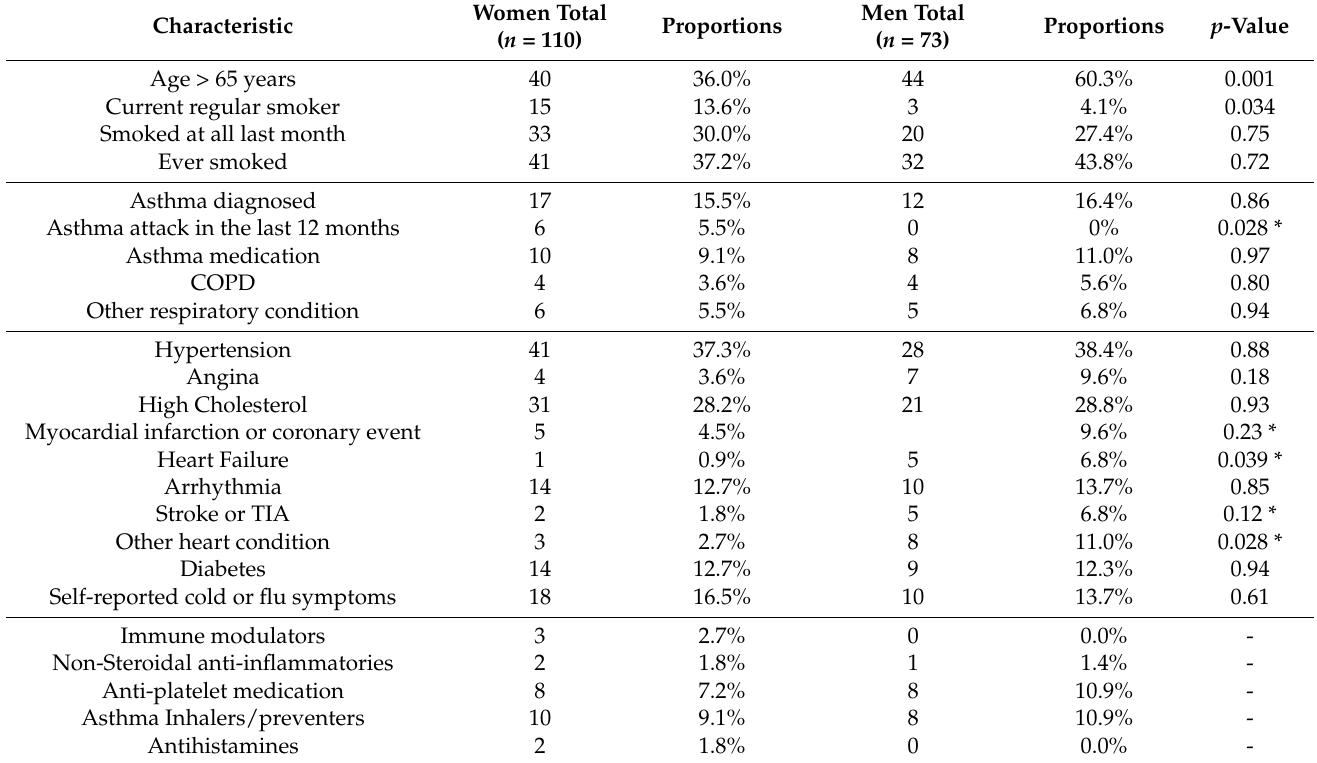
Table 2. Demographics and clinical characteristics of study